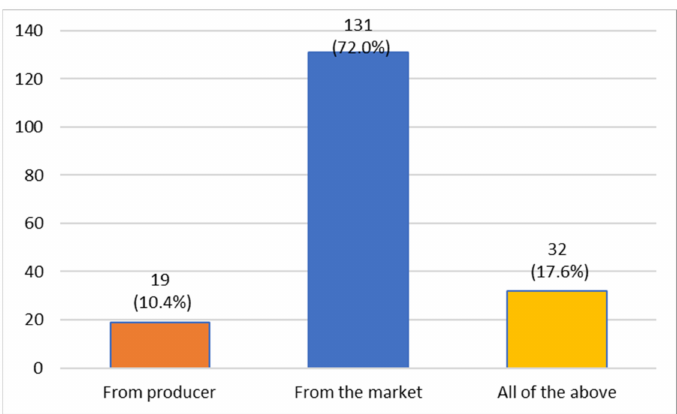
Figure 4. Distribution of the answers given by children regarding food purchased.